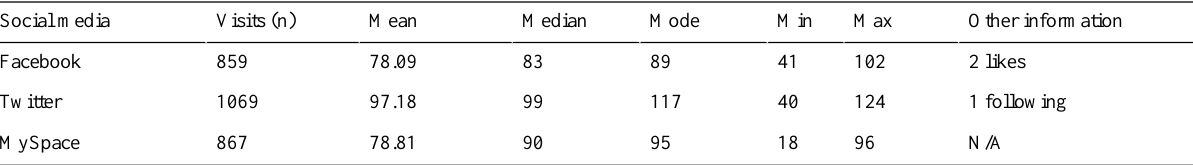
Table 2. Illicit eDTCA unique user descriptive statistics.